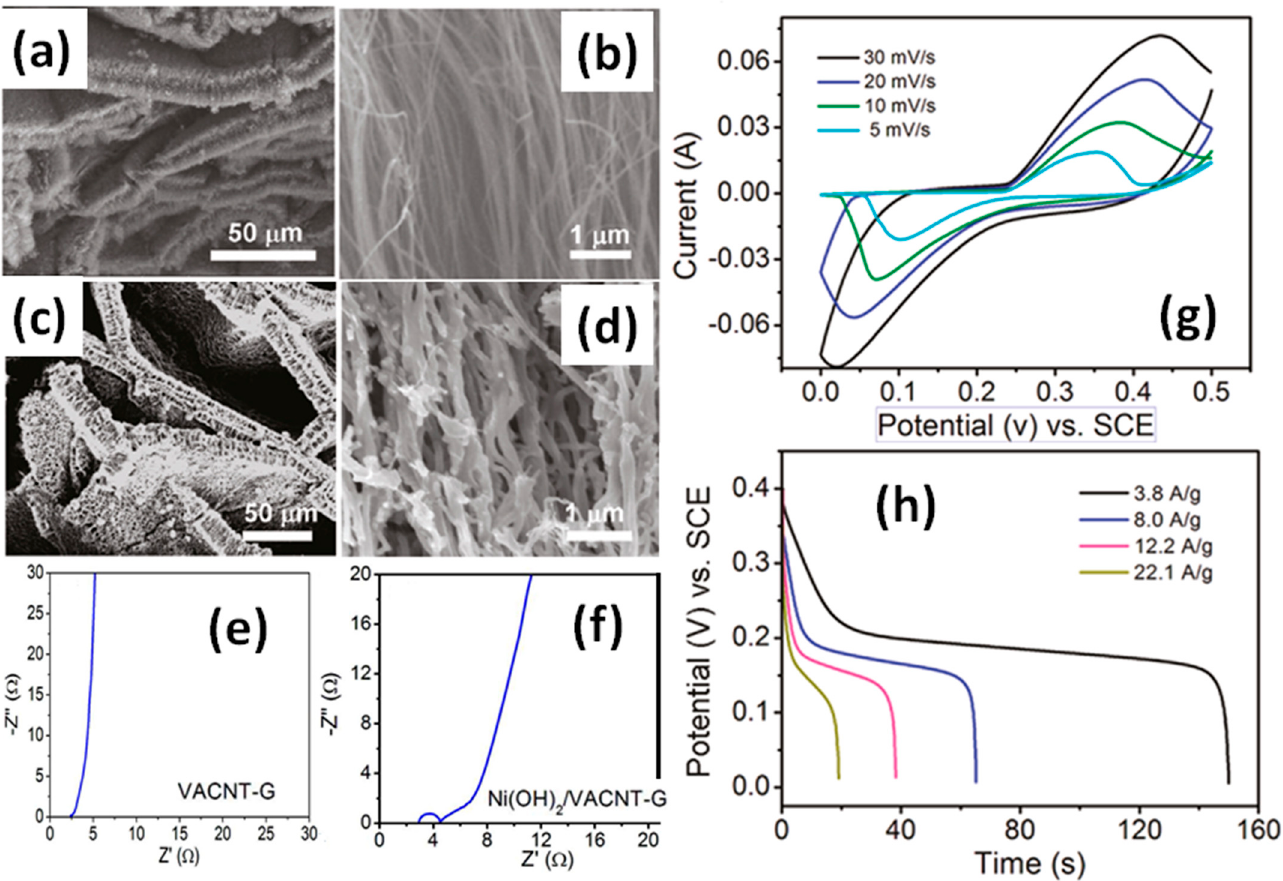
Figure 24. Typical SEM images of 3D pillared vertically aligned CNT (VACNT)-graphene architectures without ( a , b ) and with Ni(OH) 2 ( c , d ). Electrochemical impedance spectra (EIS) Nyquist plots of VACNT-graphene electrode before ( e ) and after ( f ) modification by Ni(OH) 2 . CV at different scan rates ( g ) and GCD curves at various discharge current densities ( h ) (Reproduced with permission of [59]. Copyright American Chemical Society, 2011).